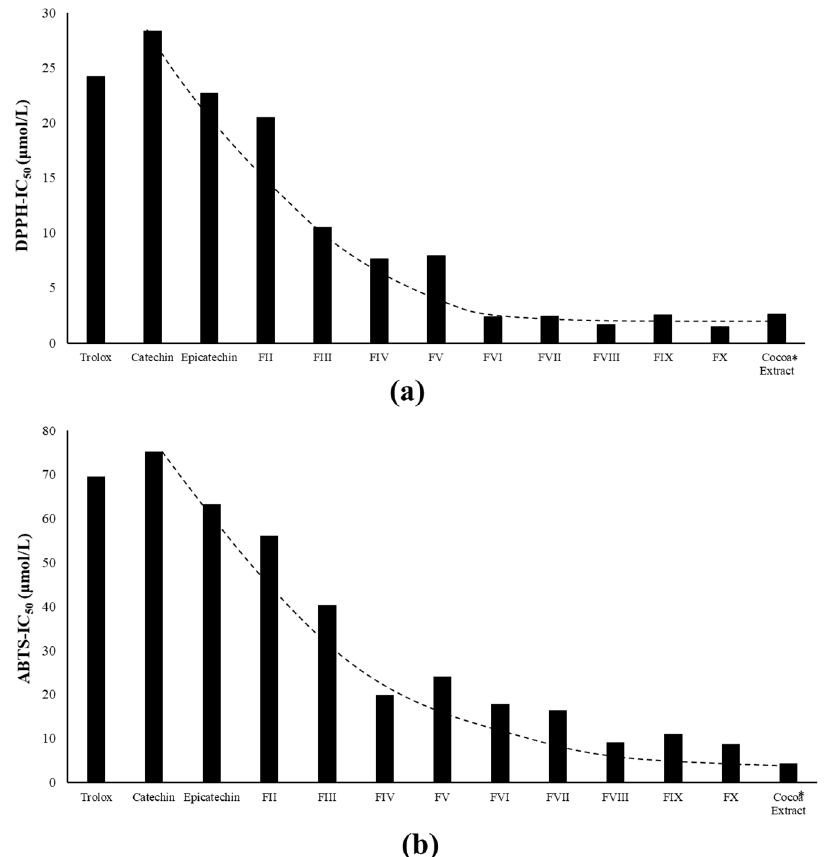
Figure 6. Antioxidant activity of cocoa extract and its procyanidins fractions by: ( a ) DPPH • -IC 50 ; and ( b ) and ABTS • + -IC 50 . Fractions II–X refer to procyanidin separation by diol-column phase (see Table 2). Cocoa extract is expressed as (–)-Epicatechin equivalents. The dotted line represents the scavenging activity trend. Procyanidins’ antioxidant activity displayed exponential behavior by increasing the degree of polymerization ranging from monomer to oligomers (up to DP ≤ 7) and slight increase for oligomers (DP ≥ 7) up to polymers.